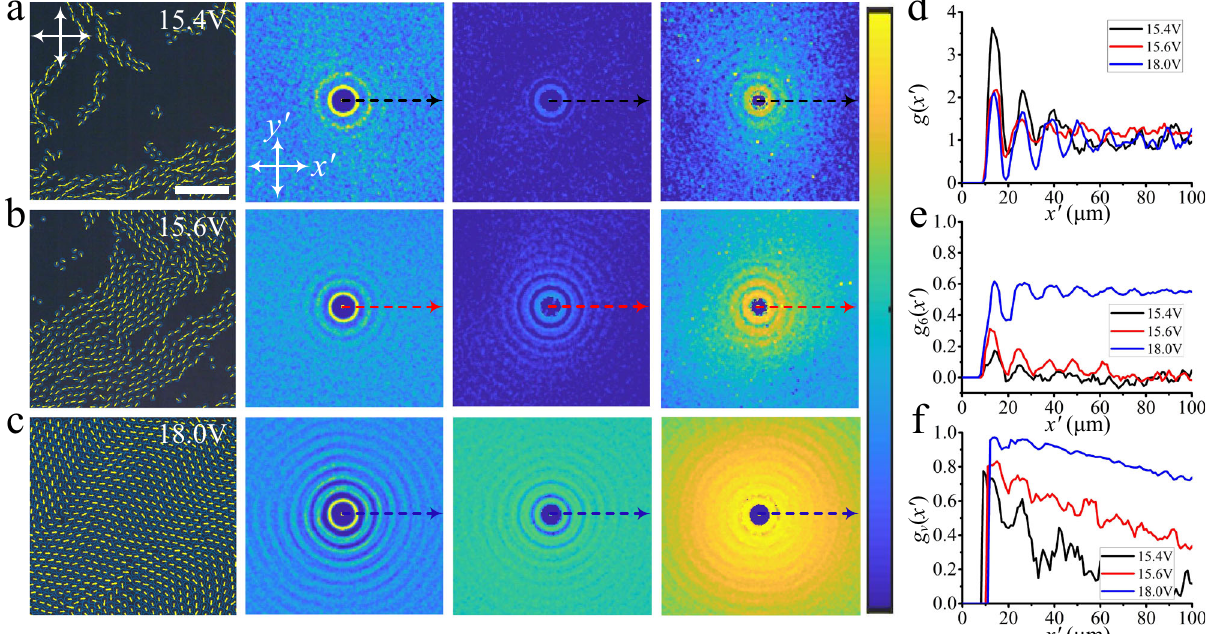
Fig. 5 Collective motion of directrons at different voltages. Micrographs ( fi rst column, scale bar 100 μ m), 2D radial distribution functions ( g , second column), 2D hexatic bond orientational correlation functions ( g 6 , third column) and 2D spatial velocity correlation functions ( g v , forth column) of the directrons at different voltages, ( a ) U = 15.4 V, ( b ) U = 15.6 V, and ( c ) U = 18.0 V. The frequency is fi xed at f = 100 Hz. The image sizes of the 2D correlation functions represent an area of 200 μ m × 200 μ m. The color bar changes linearly from 0 (dark blue) to 3 (light yellow) for g , and from 0 (dark blue) to 1 (light yellow) for g 6 and g v . The transverse pro fi les (as indicated by the dashed arrows) of the corresponding ( d ) radial distribution functions ( g(x ’ )), ( e ) bond orientational correlation functions ( g 6 ( x ’ )), and ( f ) spatial velocity correlation functions ( g v ( x ’ )). The spatial velocity correlation functions are averaged over 10 s (20